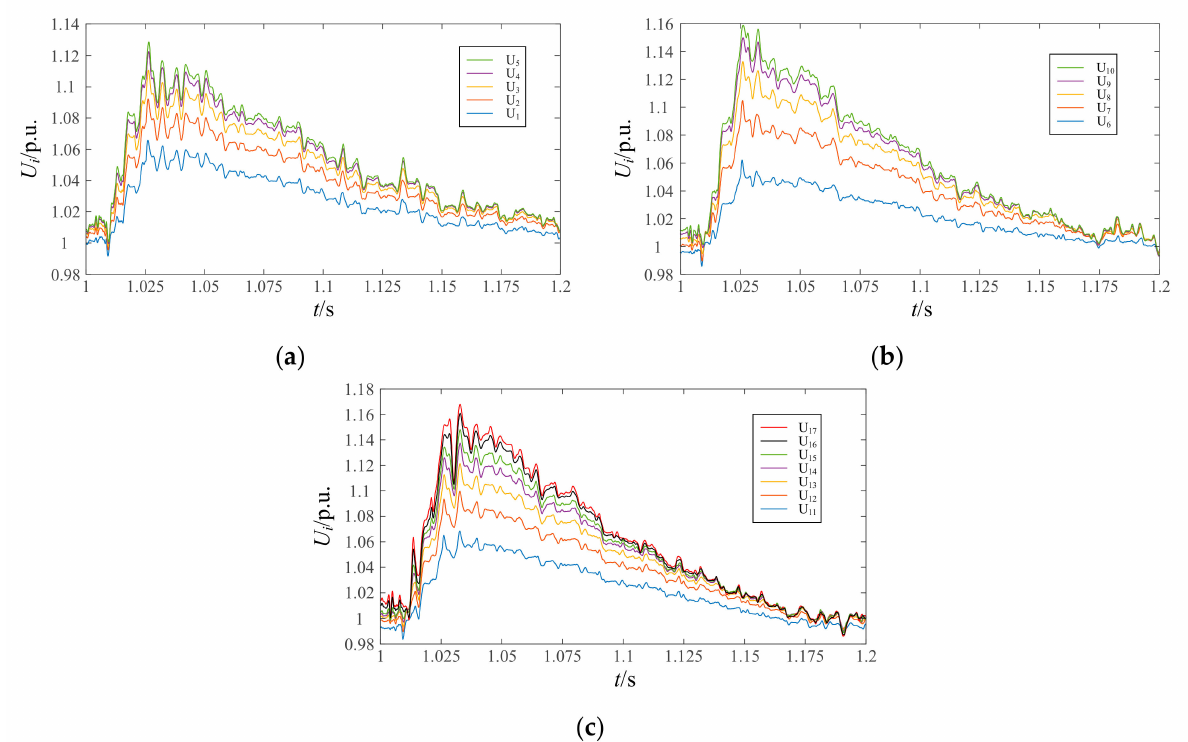
Figure 17. The partial of generator terminal voltage variation curve, adopting the proposed strategy. ( a ) Line 1. ( b ) Line 2. ( c ) Line